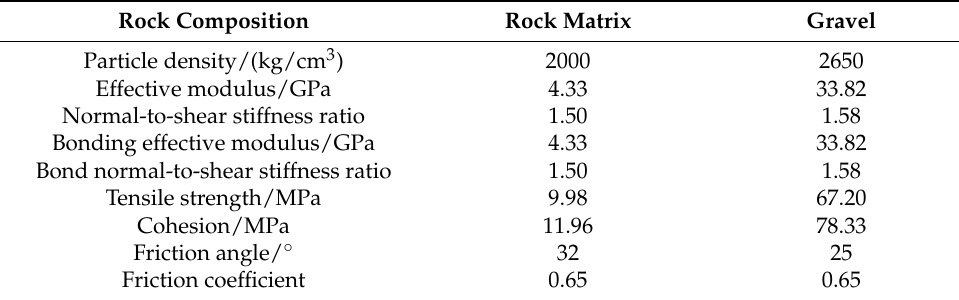
Table 2. Material parameters of the DEM pebbled sandstone models.